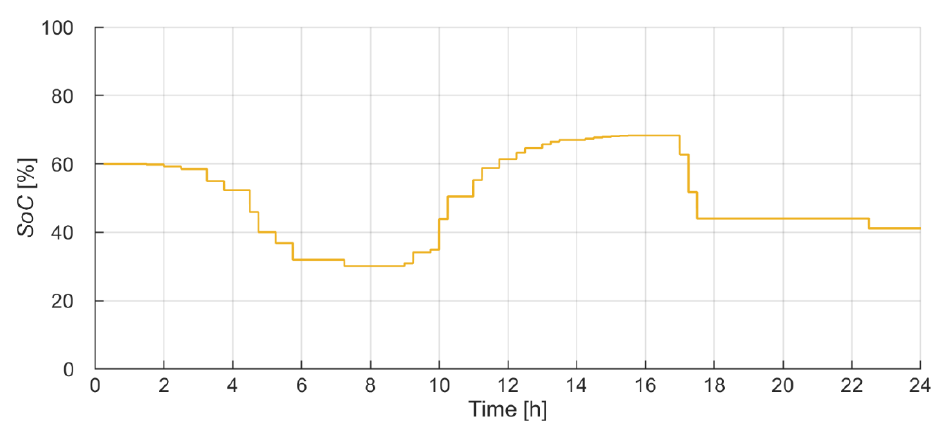
Figure 21. Daily state of charge of the energy storage unit ES_529 (installed in node 529); profile B. Table 2. The result of selecting the location and parameters of ESU for the analyzed LV grid (load profile A). Node No.